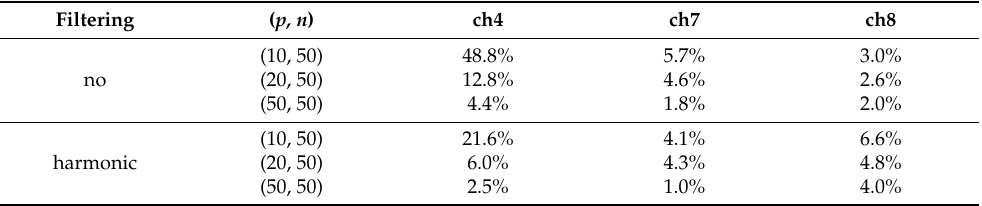
Table 12. A3S-Rec dataset: AUPRC relative percentage increase from fine-tuned baseline to best prototypical score across all the recordings of channels